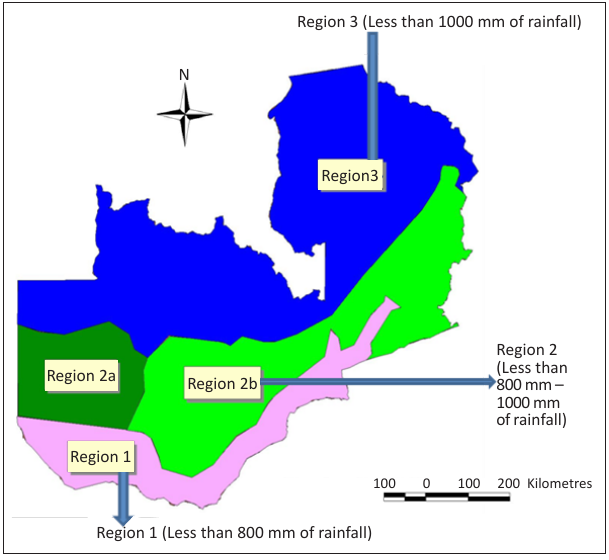
FIGURE 3: Map of Zambia showing the three agro-ecological zones.